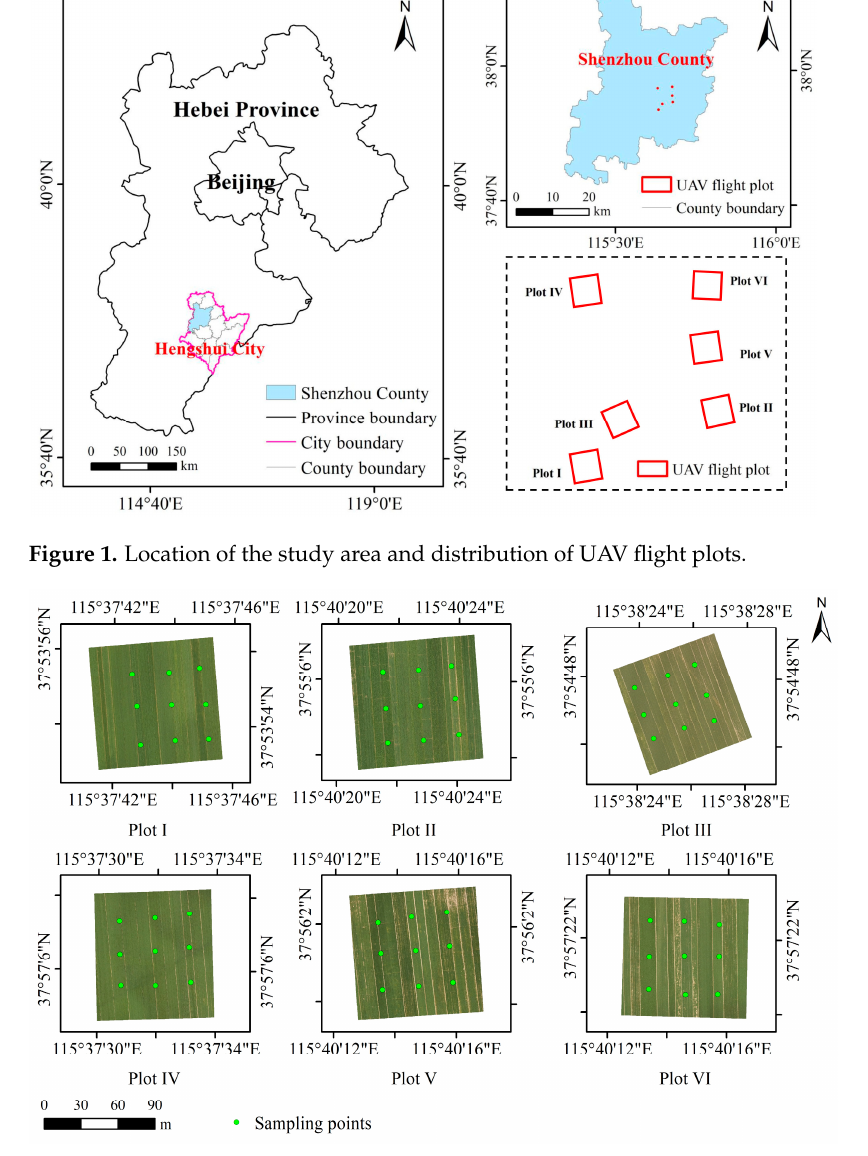
Figure 2. Ground sampling points in each UAV flight plot.